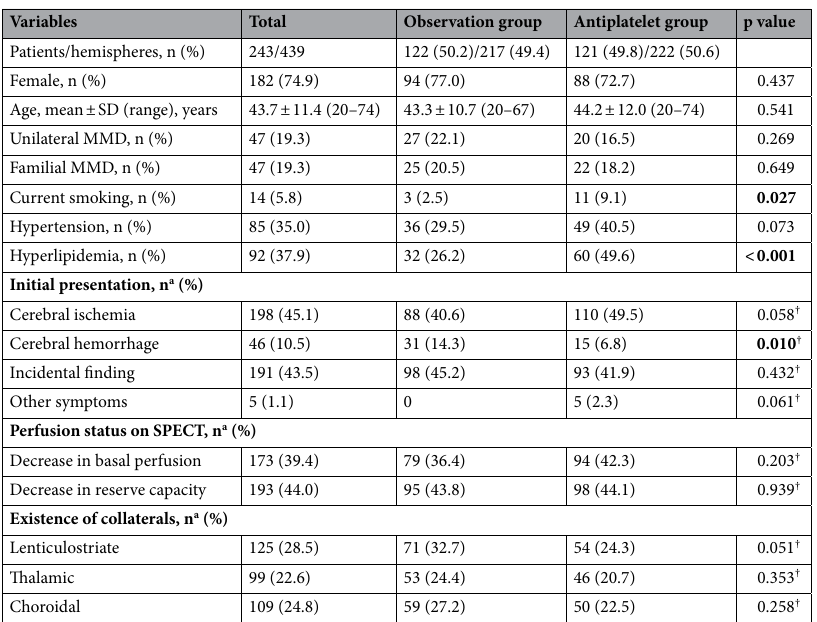
Table 1. Baseline characteristics. p < 0.05 statistically significant (marked in bold). Unless specified otherwise, values indicate the number or data of patients. MMD moyamoya disease, SPECT single photon emission computed tomography. † Logistic regression model using GEE. a Number of